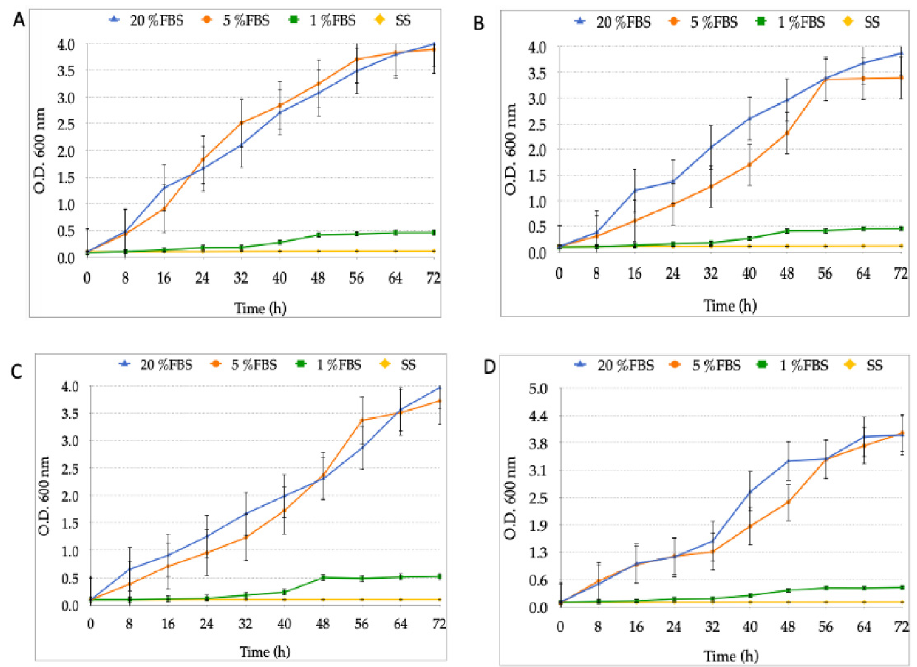
Figure 3. Growth curves of different H. pylori strains in the presence of BB supplemented with 1%, 5% or 20% FBS or SS. ( A ) H. pylori J99; ( B ) H. pylori G-27; ( C ) H. pylori SS1 and ( D ) H. pylori H707. BB: Brucella broth; FBS: fetal bovine serum; SS: saline solution.